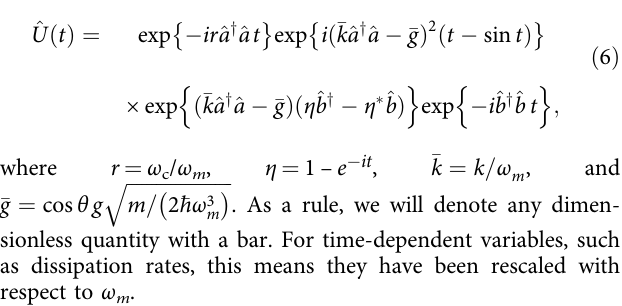
(cid:2) k ¼ 1 ; (cid:2) g ¼ 2. Both fi gures